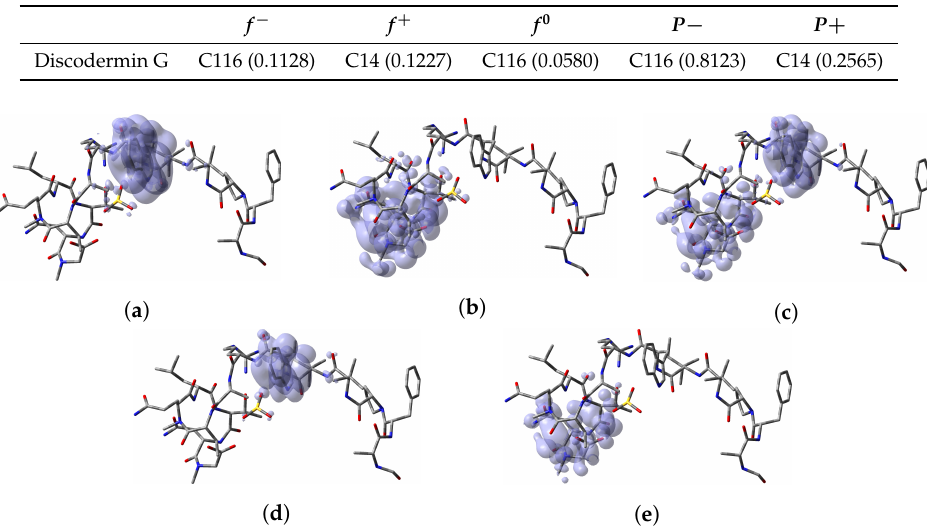
Figure A7. Graphical sketches of the local reactivity descriptors for Discodermin G showing the reactivity regions: ( a ) Electrophilic Fukui Function f − , ( b ) Nucleophilic Fukui Function f + , ( c ) Radical Fukui Function f 0 , ( d ) Electrophilic Parr Function P − and ( e ) Nucleophilic Parr Function P + . Table A8. Condensed local reactivity descriptors for Discodermin H denoting the reactivity sites:Electrophilic Fukui Function f − , Nucleophilic Fukui function f + , Radical Fukui Function f 0 , Electrophilic Parr Function P − and Nucleophilic Parr Function P +